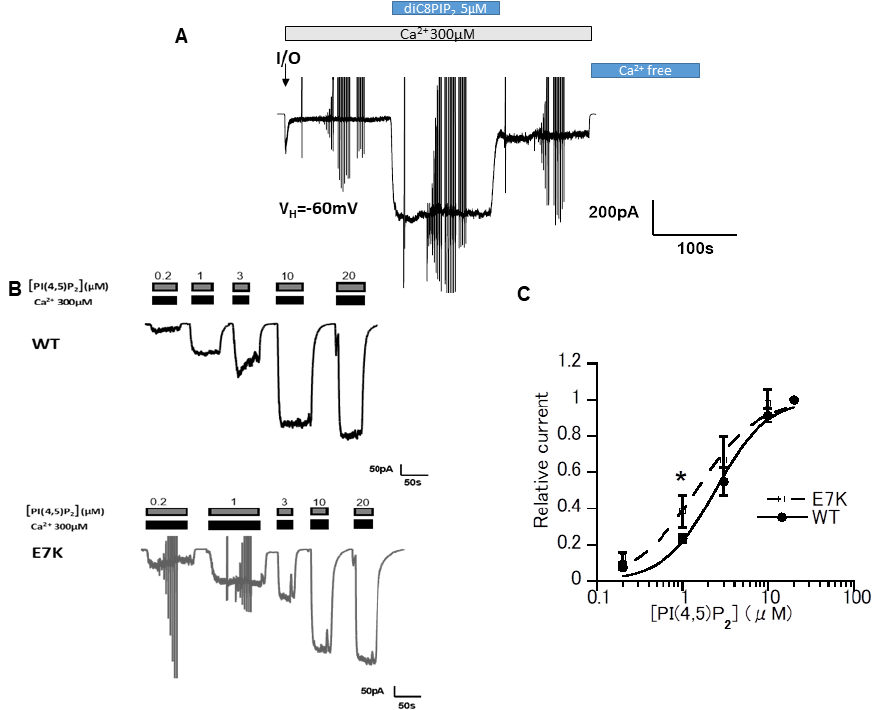
Figure 1. E7K mutant presented a higher PI(4,5)P 2 sensitivity than the wild-type (WT)-TRPM4 channel. ( A ) In the inside-out patch configuration and after the fast rundown, diC 8 -PI(4,5)P 2 (5 µ M) restored TRPM4 channel activity over its initial magnitude. Vertical deflections reflect ramp- or step pulse-induced currents. ( B ) Representative data from two inside-out patch membranes (WT and E7K) demonstrating the dose-dependent reactivation of TRPM4 channels in response to various concentrations of diC 8 -PI(4,5)P 2 . ( C ) The degree of reactivation by diC 8 -PI(4,5)P 2 (relative current) is defined as (I [x] − I [post-desens] )/(I [20μM diC8-PIP2] − I [post-desens] ), where I [x] and I respectively denote the ampli- tudes of TRPM4 currents reactivated by given (‘X’ μM) and maximal (20 μM) concentrations of diC 8 -PI(4,5)P 2 , and I [post-desens] is that of the basal TRPM4 current after desensitization to 300 μM Ca 2+ [13]. Averaged concentration-response curves for the TRPM4 channel reactivation by diC 8 -PI(4,5)P 2 are fitted by the Hill-type equation: 1/(1 + (EC 50 /[diC 8 PIP 2 ]) n . It gives EC 50 values of 2.40 ± 0.23 μM and 1.44 ± 0.20 μM; Hill coefficient (n) values of 1.5 and 1.2 for WT and E7K, respectively. * p < 0.05 with ANOVA followed by Tukey’s post hoc tests ( n = 5).